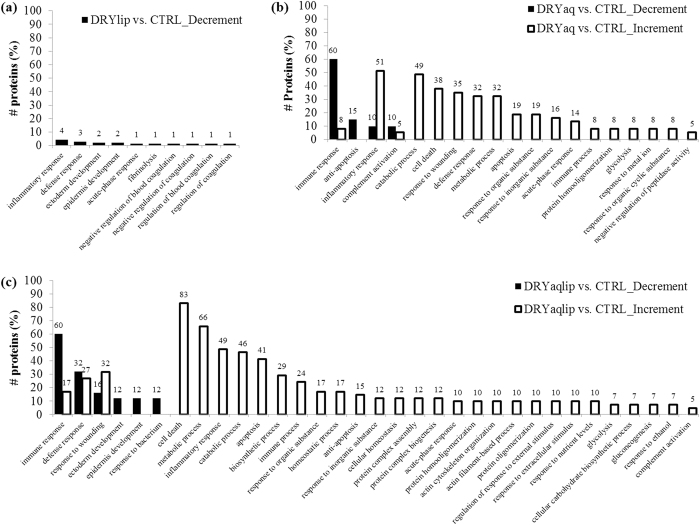
The bar charts shows the over-represented GOBP terms associated with the differentially expressed proteins analysed employing the DAVID tool in (a) DRYlip vs. CTRL, (b) DRYaq vs. CTRL and (c) DRYaqlip vs. CTRL.